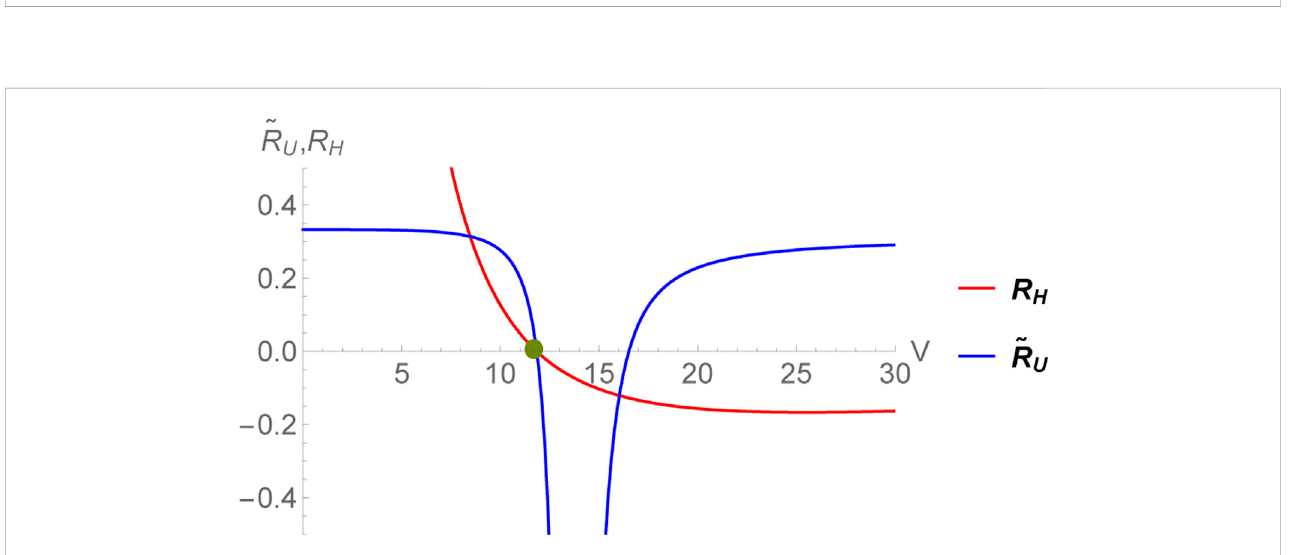
FIGURE 3 Zero crossing of ~ R U and R H (with C V =0) for the RN-AdS black hole plotted versus thermodynamic volume V with q =1, T